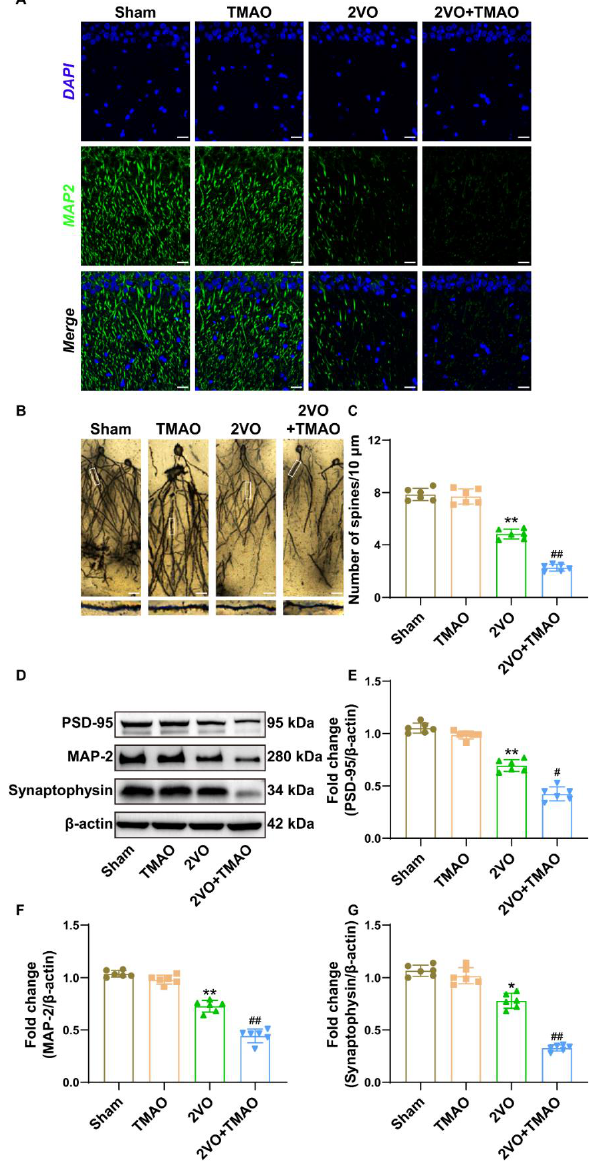
Figure 3. TMAO attenuated hippocampal synaptic plasticity within 2VO rats. ( A ) Representative immunostaining showing the neuronal structures stained with MAP-2 (green) within the hippo- campal CA1 area. Nuclei were subjected to DAPI staining. Scale bar, 20 μm (n = 6). ( B ) Representa- tive imaging for Golgi-stained neuronal structures within the hippocampus. Scale bar, 20 μm. Mi- crographs are shown at 200× (n = 6). ( C ) Quantification of apical dendritic spine densities is shown as a bar chart (n = 6). ( D ) Representative bands of PSD95, MAP-2, and synaptophysin protein ex- pressions within the rat hippocampus across the groups. β -actin served as a loading control (n = 6). Quantitative assessment for ( E ) PSD95, ( F ) MAP-2, and ( G ) synaptophysin protein expression is